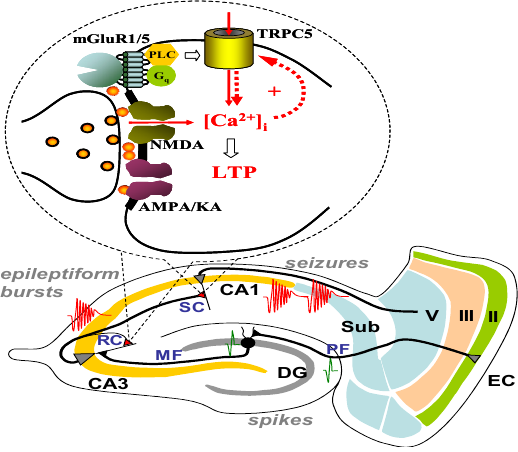
CA3. EC: entorhinal cortex; DG: dentate gyrus; MF: mossy fiber; RC: recurrent